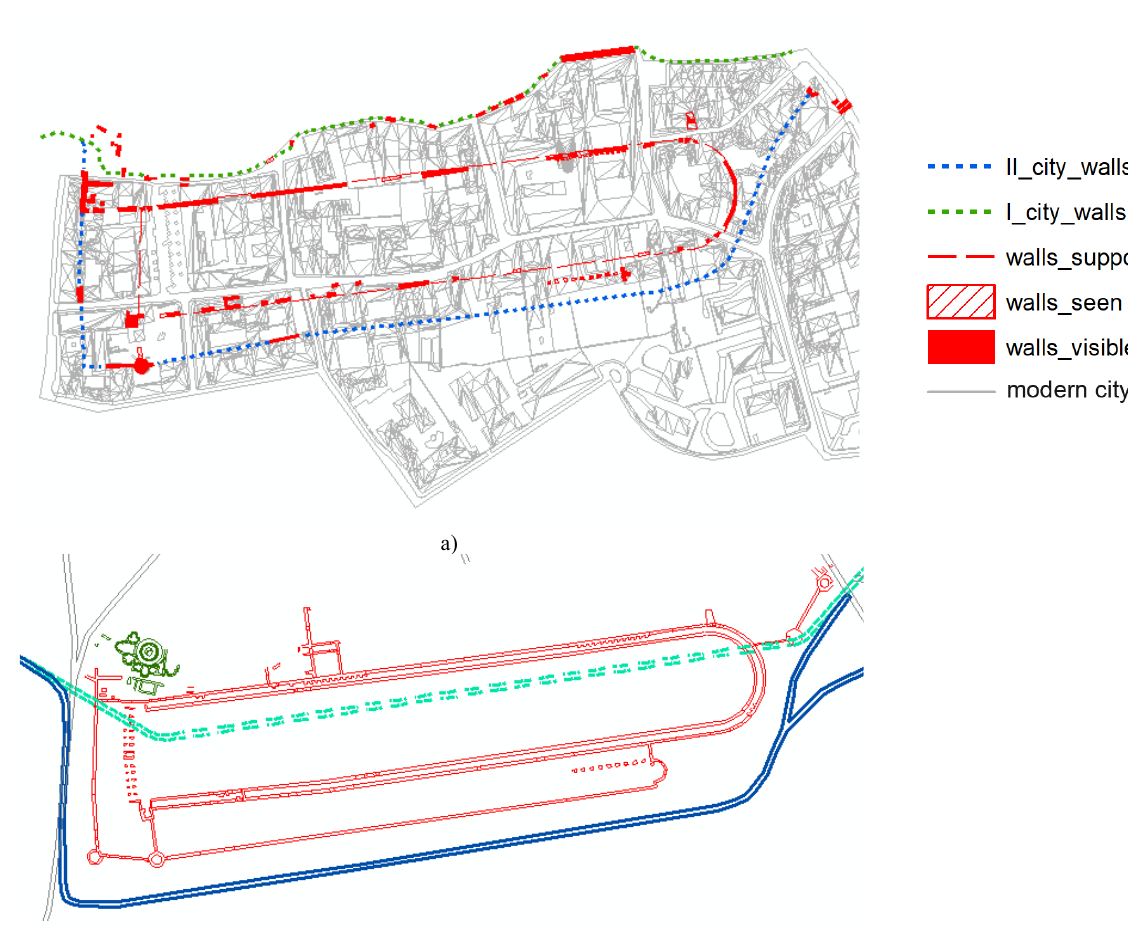
Figure 6. Georeferenced representation of the circus maps corresponding to different periods in time: a) De Capitani’s map indicating the different information about the walls of the circus excavated or guessed; b) Mirabella Roberti’s update highlighting the different paths of the river, before (light blue) and after the intervention (dark blue) for building the circus.